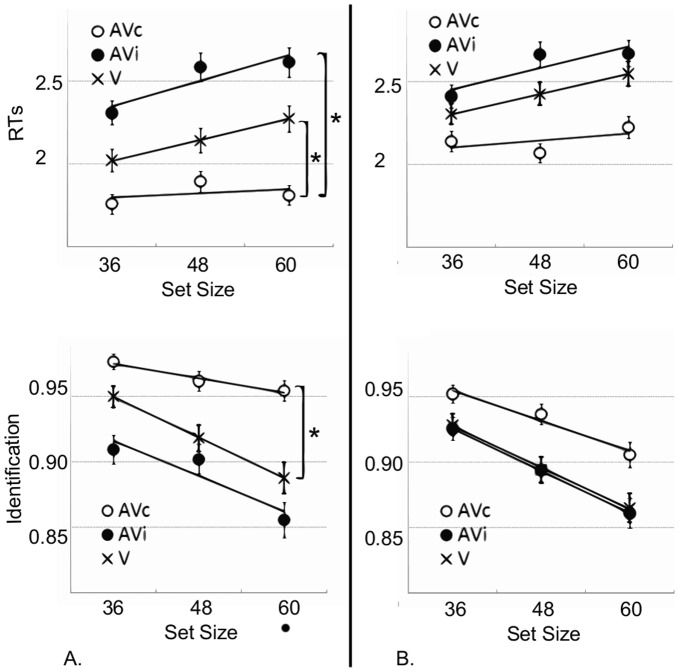
Grouped RTs and identification rates as a function of set size.Grouped RTs (upper panels) and identification rates (lower panels) as a function of set size for temporal rates under (A) and above (B) 1.4 Hz. Bars are two SEM. In the below 1.4 Hz group, slopes in AVc are shallower than in AVi and V conditions; this suggests that visual search is less impaired by distracters in AVc. In the above 1.4 Hz group, no significant differences in slopes were found.